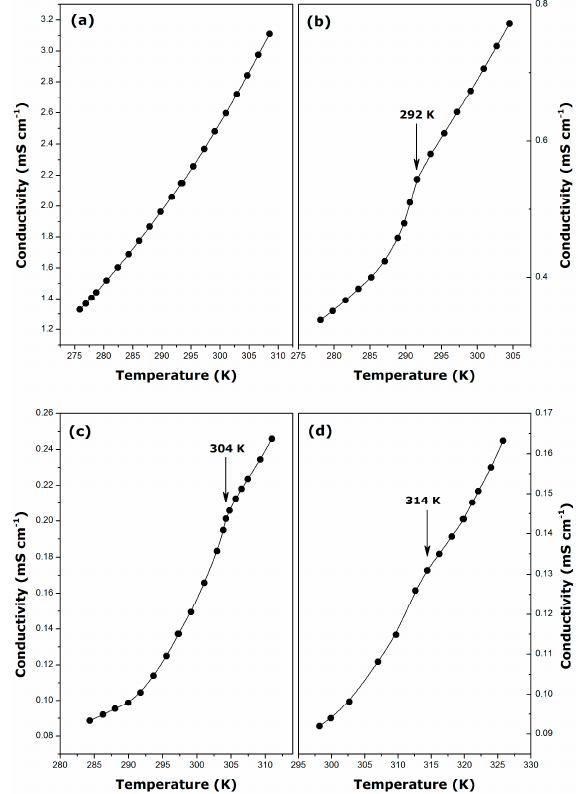
Figure 2. Plots of the specific conductance against temperature for micellar aqueous solutions of guanidinium cationic surfactants: ( a ) DGC ( m = 31.72 mmol·kg − 1 ); ( b ) DDGC ( m = 8.01 mmol·kg − 1 ); ( c ) TDGC ( m = 2.55 mmol·kg − 1 ); and ( d ) CGC ( m = 0.7 mmol·kg − 1 ).